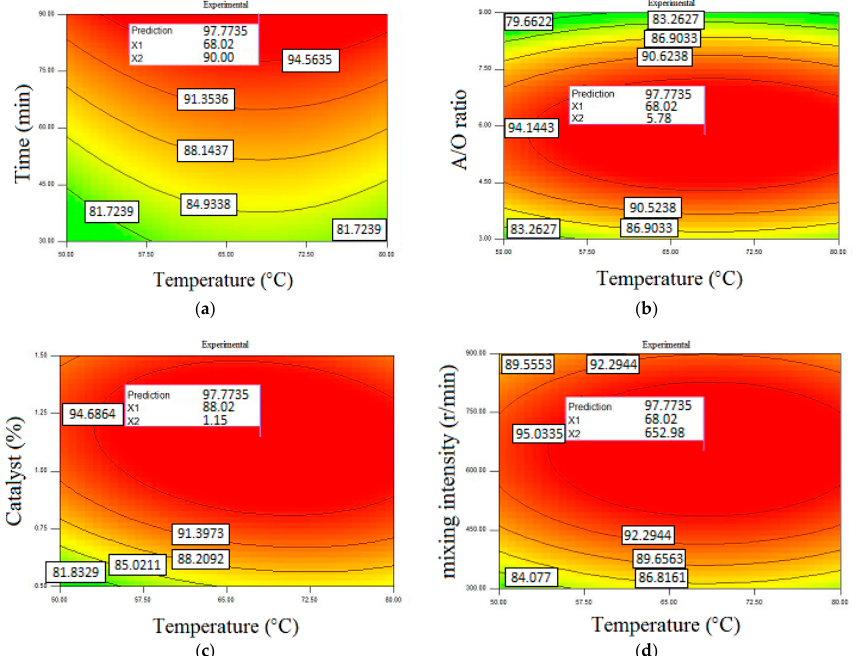
Figure 6. The optimization condition of ethyl ester production in the case of importing experimental data. ( a ) Response surface based on time (min) and temperature (°C); ( b ) response surface based on A/O and temperature (°C); ( c ) response surface based on catalyst (wt. %) ratio and temperature (°C); and ( d ) response surface based on mixing intensity (r/min) and temperature (°C).